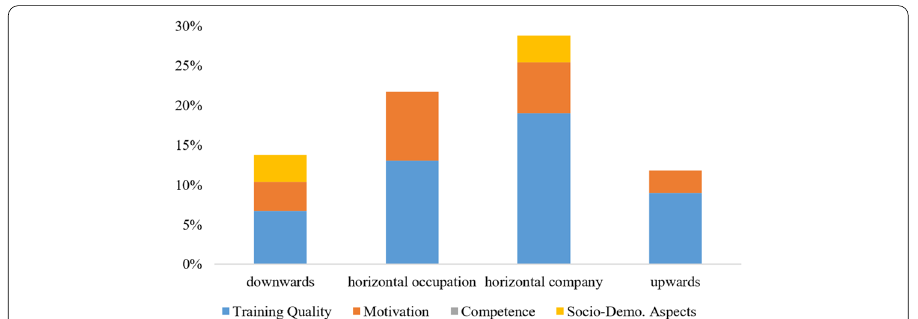
Fig. 2 Influence factors on drop-out intention with respect to direction (visualized as R 2 of global